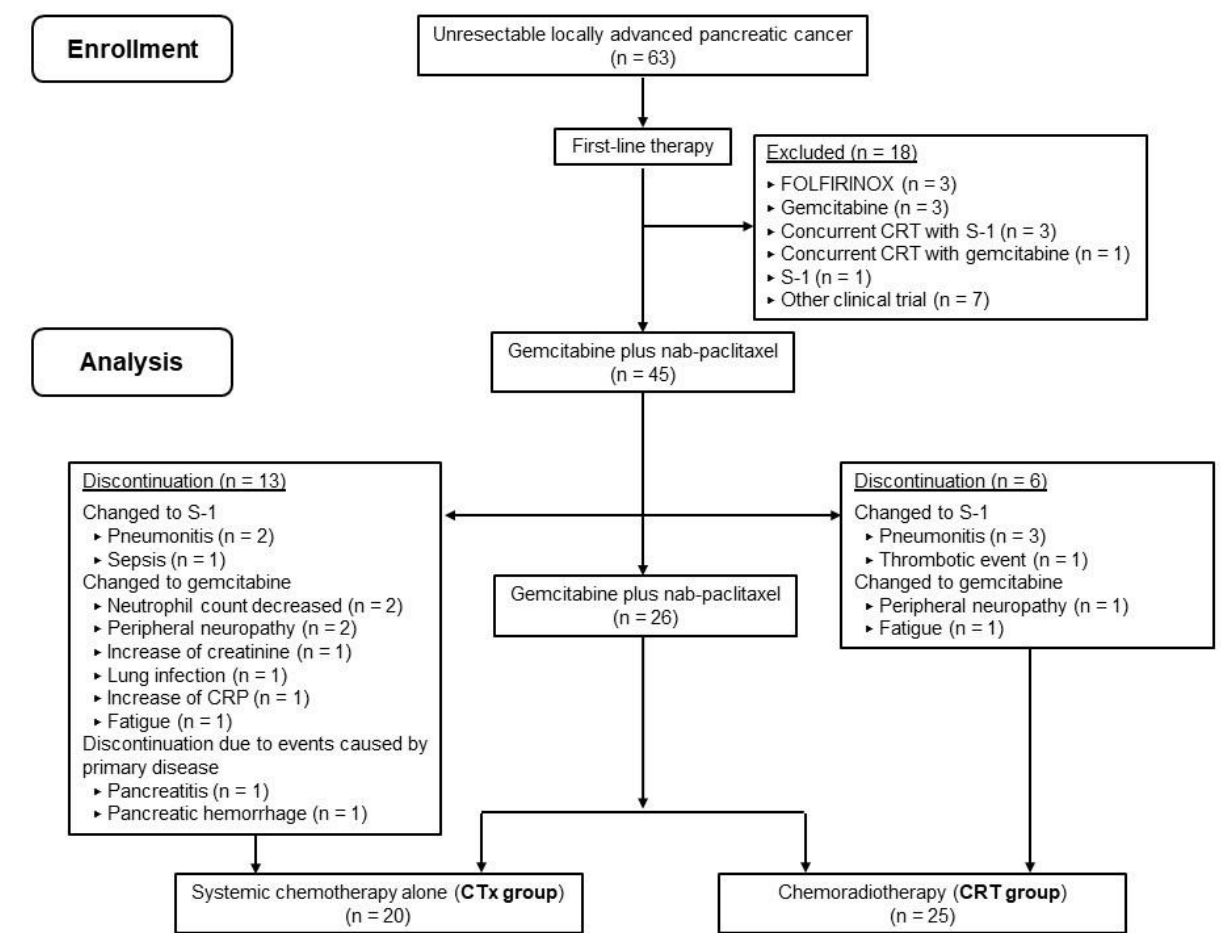
Figure 1. Consort flow diagram of the treatment strategy for unresectable locally advanced pancreatic cancer in our de- partment.